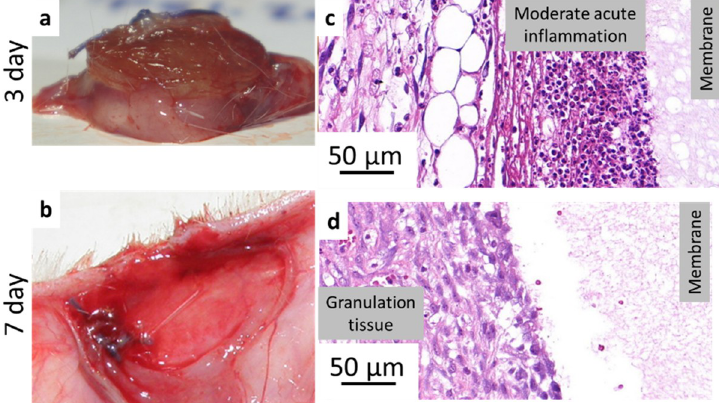
Fig 6. PASPCYS sample resected 3 days after implantation (a) and a representative image from histopathology (c); implantation area without sample after 7 days after implantation (b), a representative image from histopathology